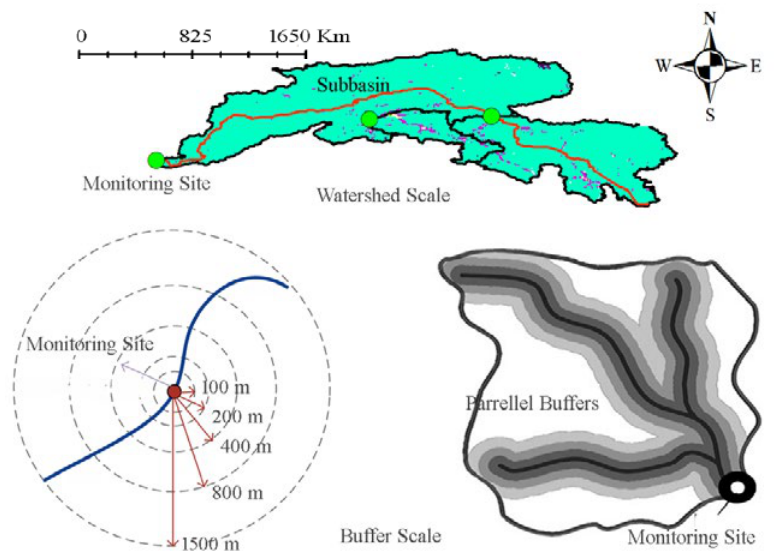
Fig. 1: Watershed scale and buffer scale techniques used for water quality explanatory variables identification